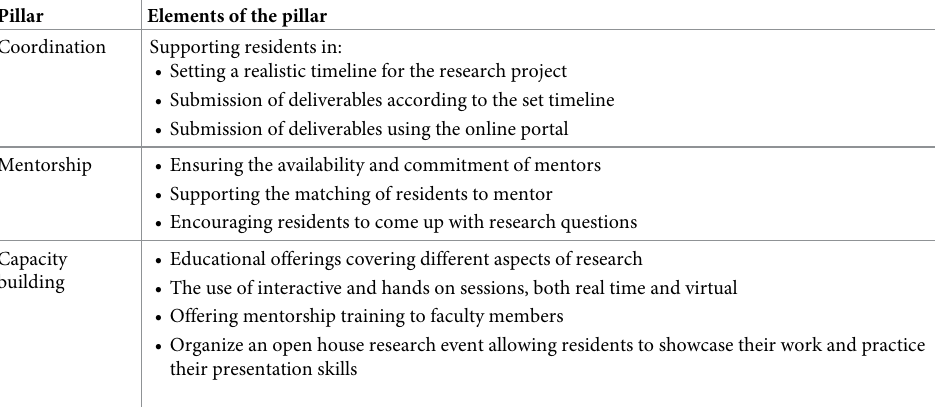
Table 1. Elements pertinent to each of the three pillars of a residency research